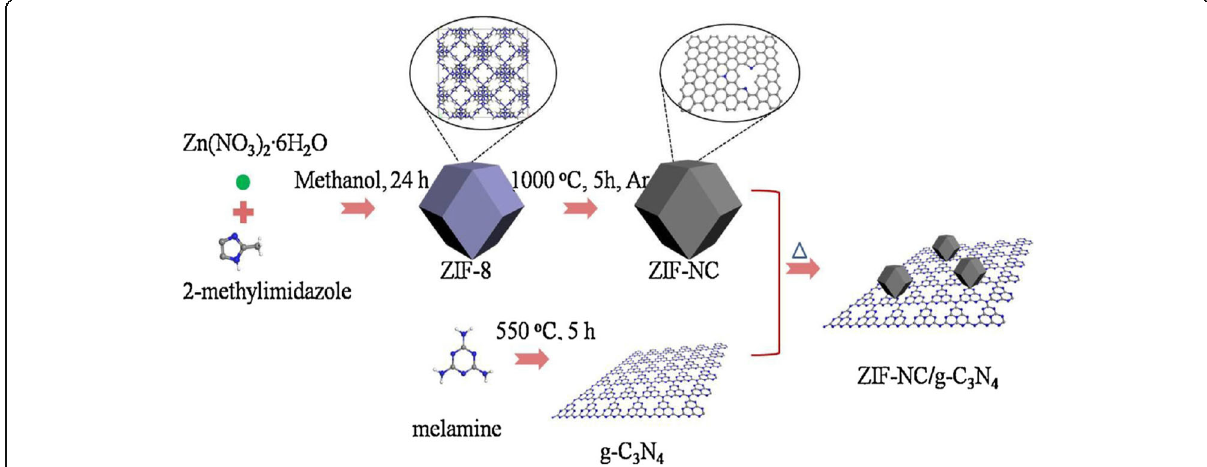
Fig. 9 Schematic illustration of the formation of ZIF-NC/g-C 3 N 4 composite. Reproduced with permission [24]. Copyright 2018 Elsevier B.V